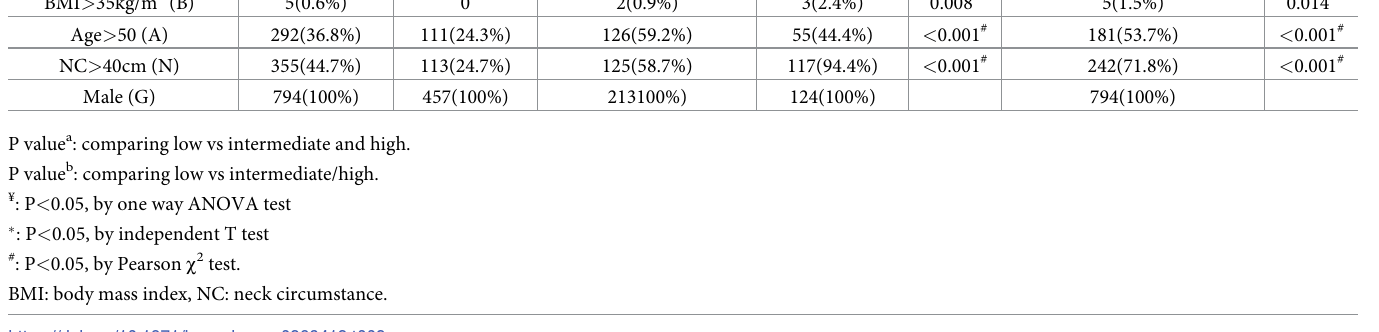
BMI (Fig 3, Model 2), age, BMI plus cardiovascular risk factors (smoking, hypertension, diabe-